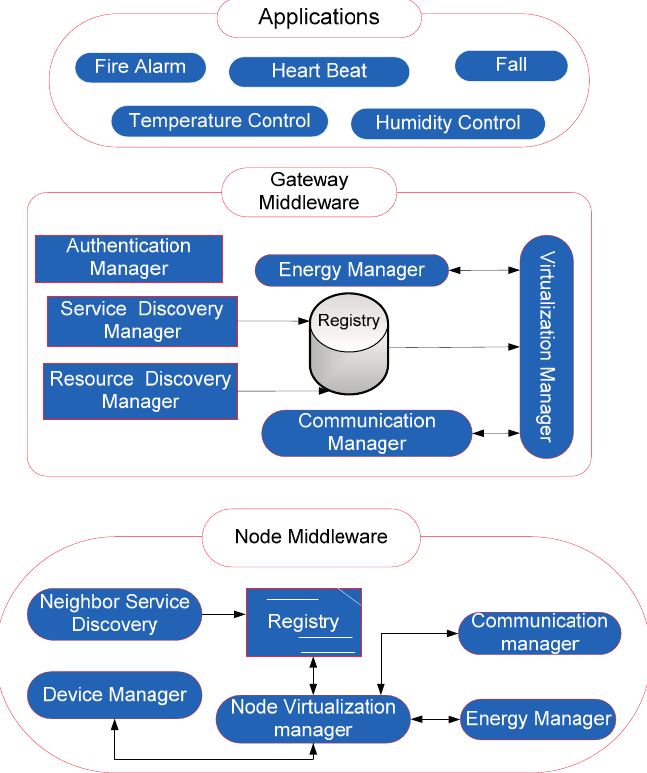
Figure 5. Proposed middleware